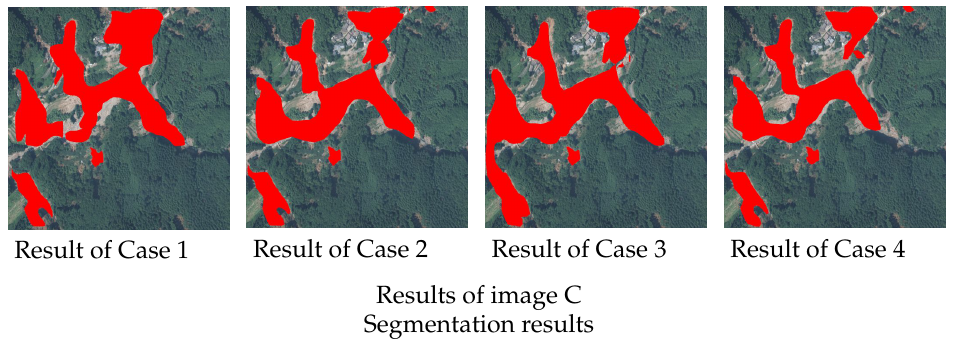
Figure 4. Segmentation results (Examples of detectable cases). The images in first and second lines show the original aerial photographs and the ground truth, which indicates the area of slope failure regions in red in the aerial photograph, respectively. The images in the third to fifth lines show the results of detecting slope failure regions for images A, B, and C shown in the first line, respectively. The detection results are shown in the order of Case 1, 2, 3, and 4 from the left to right. Even if the slope failure region has a complex shape, the slope failure regions can be recognized in all detection results.